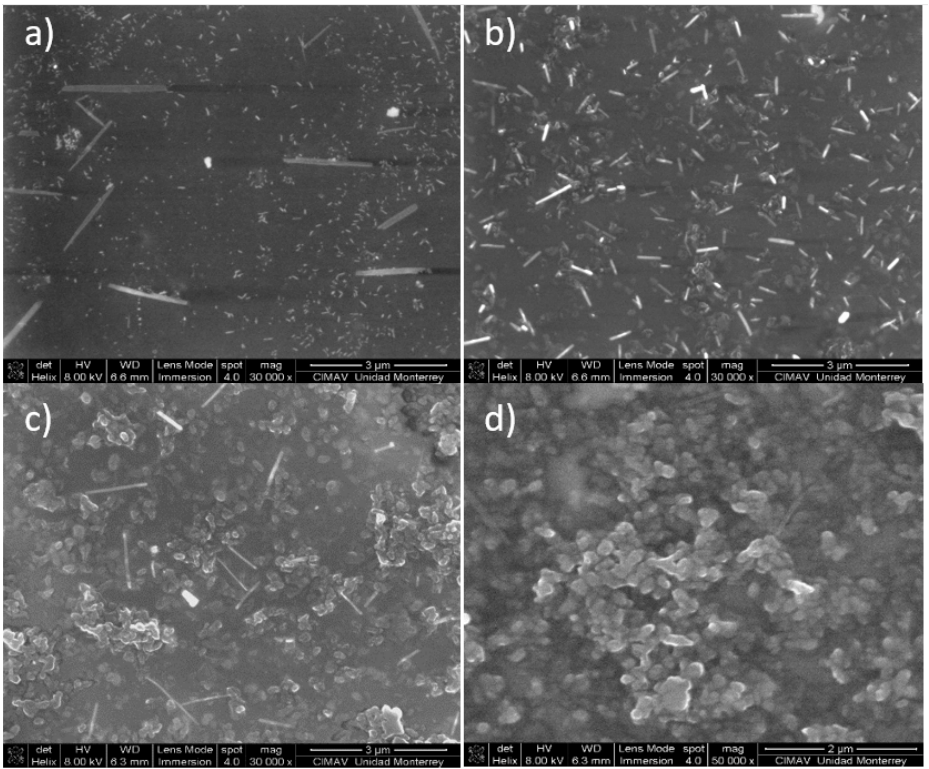
Figure 17. SEM micrographs of purified PVA–PANI thin films and its morphologic variations at ( a ) low